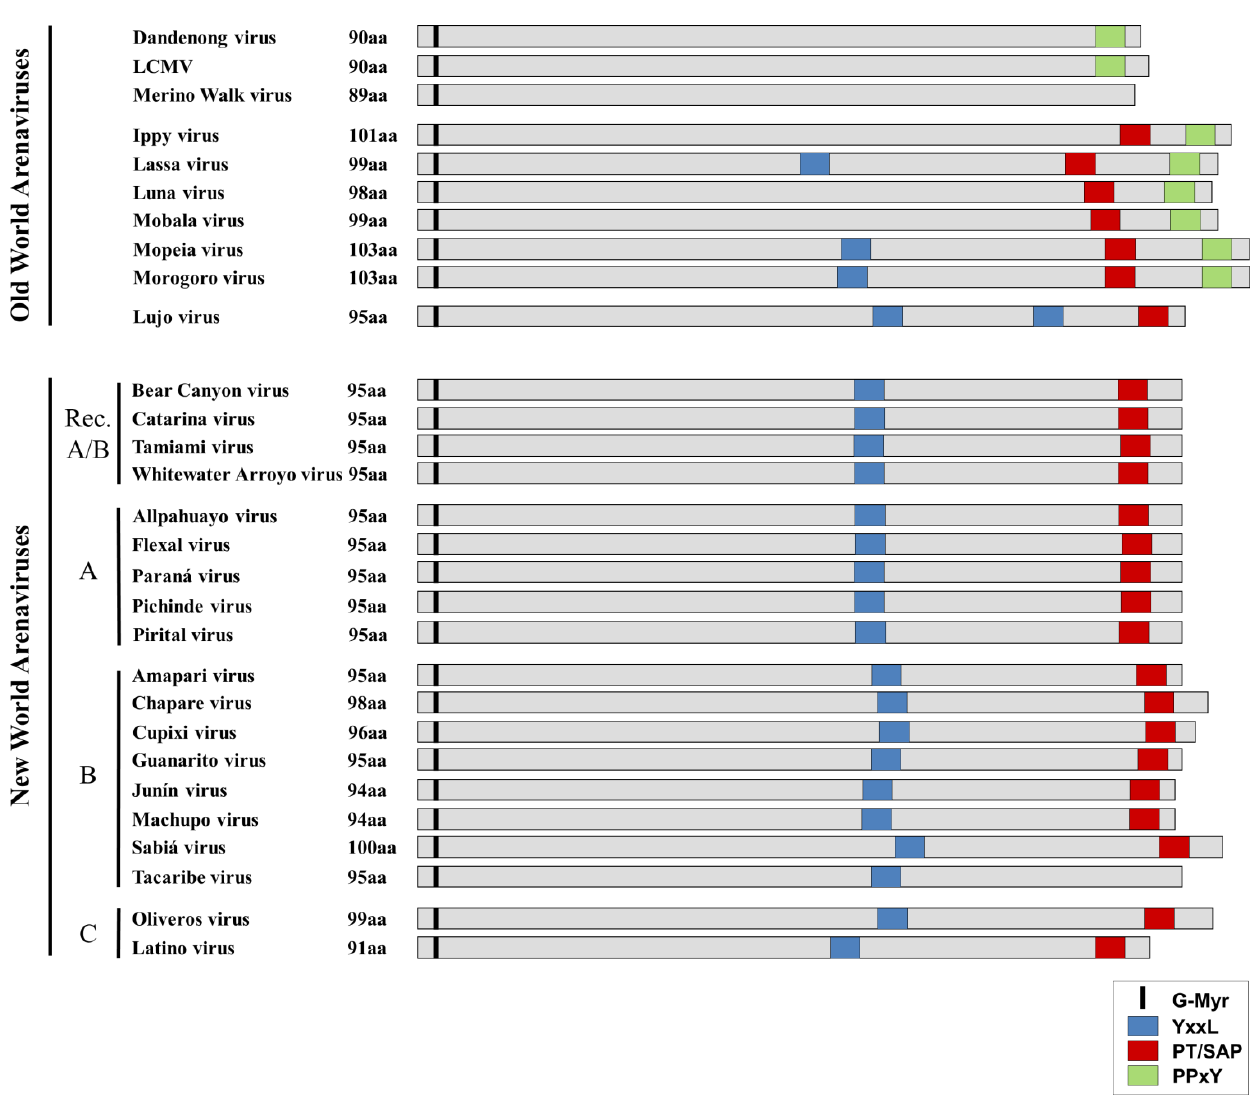
Figure 4. Comparison of late-domain arrangements in Old World and New World Arenaviruses. The locations of both putative and functional late domains for the various arenaviruses are shown. YxxL motifs are shown in blue, while PT/SAP motifs are shown in red and PPxY motifs are shown in green. The conserved glycine residue at which myristoylation occurs is indicated in black. Viruses are grouped according to their phylogenetic relationships (e.g. Old World/New World, Clade A, B, C or Recombinant (Rec.